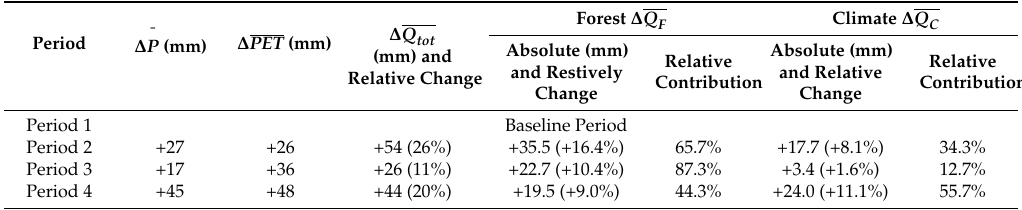
Table 4. Attribution of forest composition change and climate variability to mean annual streamflow change.